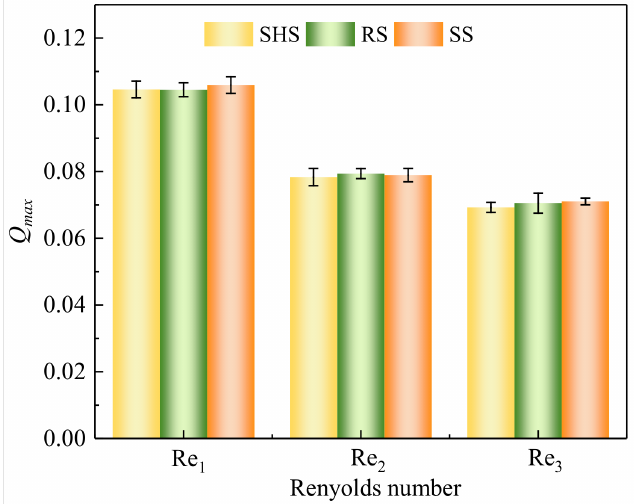
Figure 3. Q max at different Reynolds numbers. Note: SHS, RS, and SS are the superhydrophobic surface, riblet surface, and smooth surface,